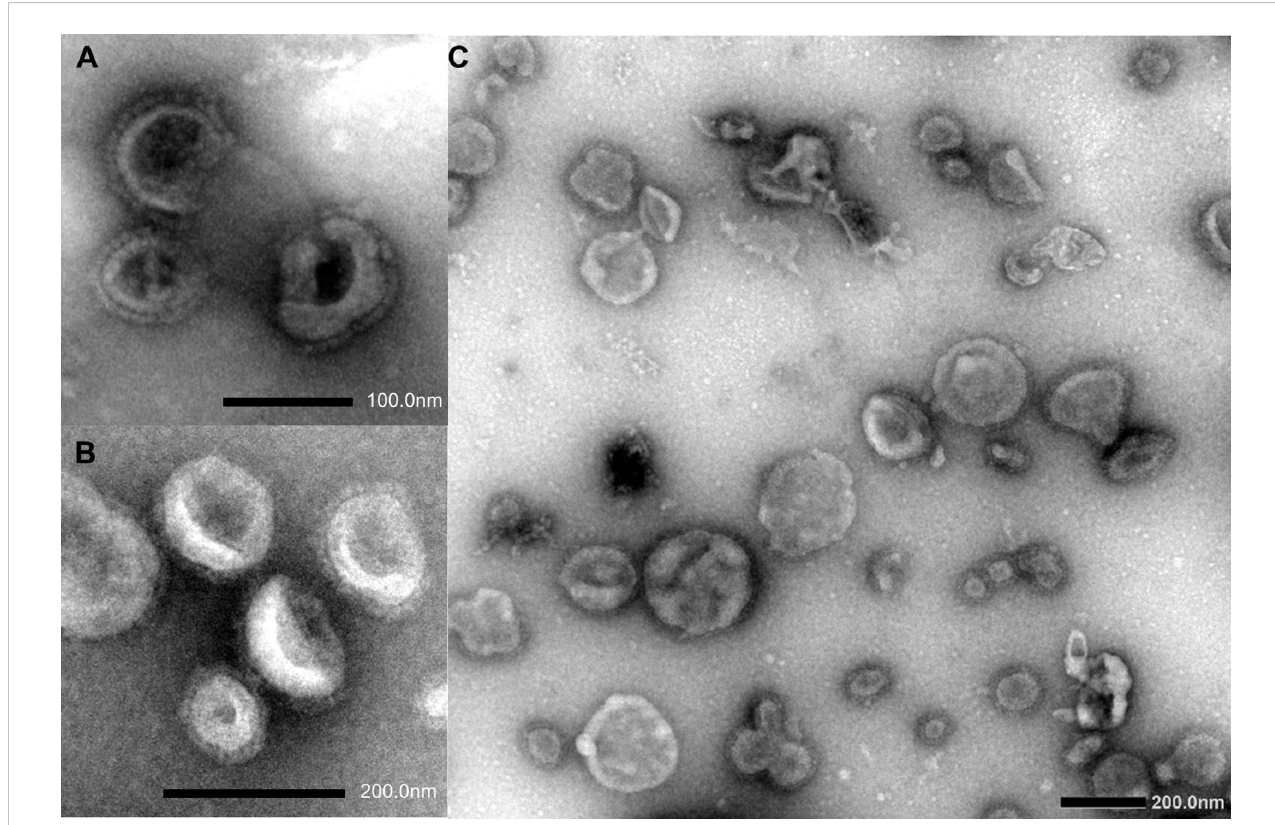
FIGURE 4 Negatively-stained transmission electron microscopy images of plant-produced Newcastle disease VLPs consisting of Fusion (F) (A) , hemagglutinin- neuraminidase (HN) (B) , or F + HN glycoproteins (C)